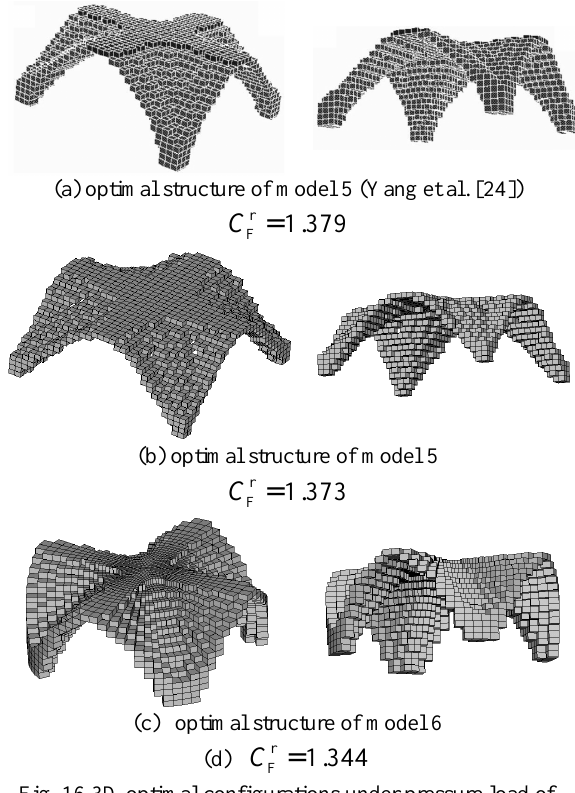
Fig.14 Influence of H/L upon the optimization results